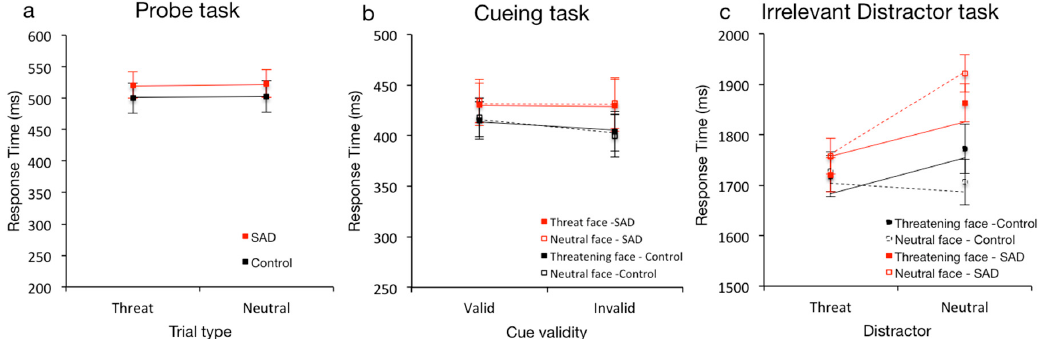
Figure 2. Results for the ( a ) probe, ( b ) cueing and ( c ) irrelevant distractor tasks. The lines represent predictions from the statistical models (see text for details). The error bars show the standard error of the mean (SEM). Note the difference in scales between the panels.